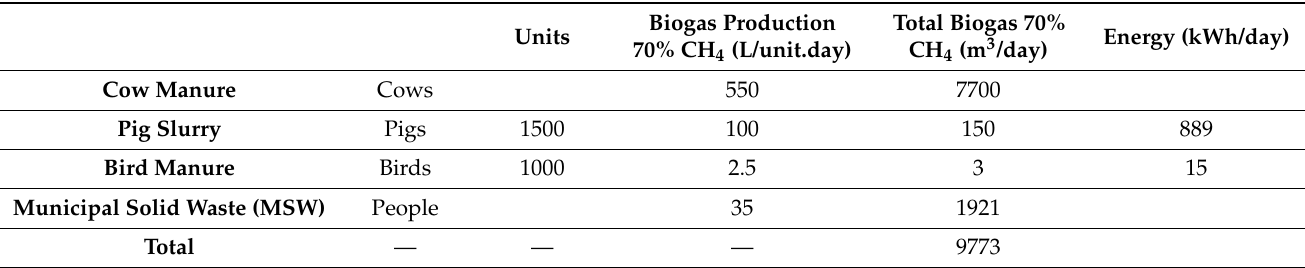
Table 6. Simulation of waste-to-energy (WtE) based on the methane production in Terceira Island. Source: